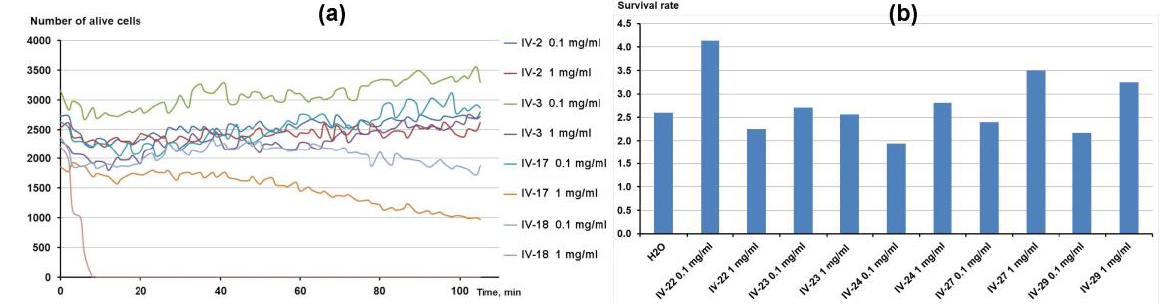
Figure 4. Toxicity to Tetrahymena of the fractions obtained by ion-exchange chromatography. ( a ) Activity determination in short-time experiment. ( b ) Activity of fractions at 24 h experiment. Survival rate is the ratio of the number of live ciliates after 24 h of incubation to the number of ciliates at the beginning of the experiment. Three independent measurements were performed for each fraction. For all fractions, the coefficient of variation (CV) did not exceed 0.07, or 7% of the mean. Fraction IV-18 was separated by reversed-phase chromatography and two peaks 1 and 2 (Figure 1c) were obtained and named IV-18-1 and IV-18-2, respectively. Interestingly, the separation of fraction IV-17 under the same conditions resulted in a similar profile; the only difference was that peak 1 was higher than peak 2. As fractions IV-17 and IV-18 were not well separated (Figure 1b), we believe that peak 1 corresponds to IV-17 and peak 2 to IV-18. So, we studied further the fraction corresponding to peak 2 (IV-18-2).